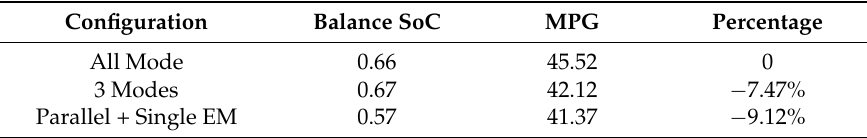
Table 4. Fuel Consumption over UDDS